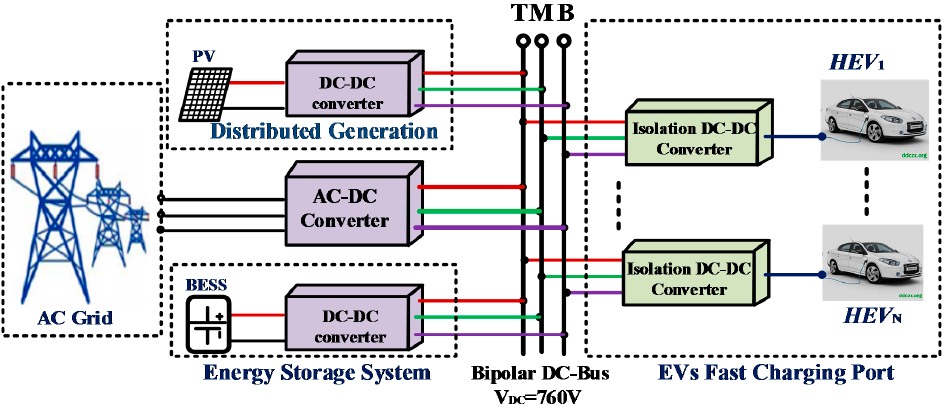
Figure 1. System block diagram of a fast electric vehicle (EV) charging station based on the common DC bus.